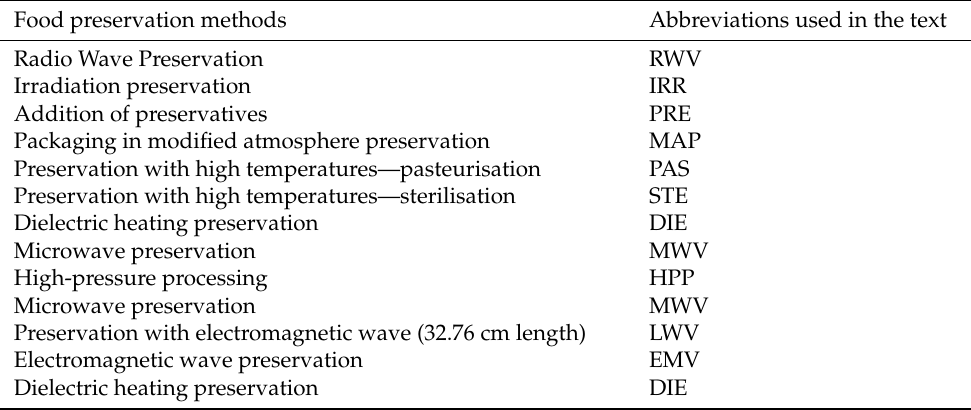
Table 3. Designation of the analysed